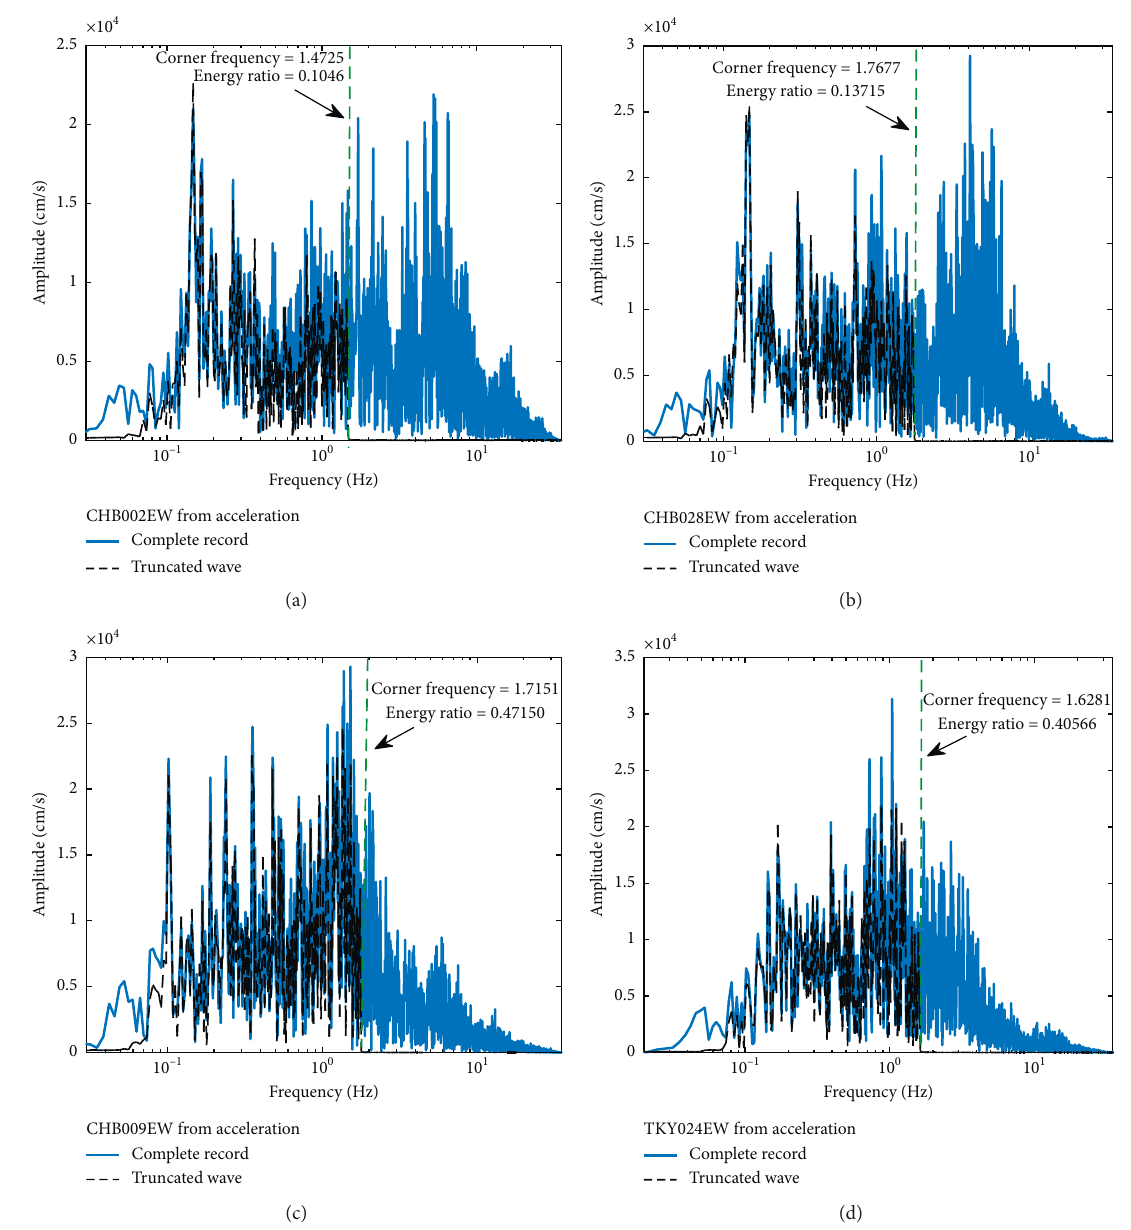
Figure 10: Comparisons of the Fourier amplitude spectra in terms of the complete record and truncated wave; (a) and (b) false positive records from CHB002EW and CHB028EW; (c) and (d) positive records from CHB009EW and TKY024EW. The Fourier amplitudes for the complete record and truncated waves are represented with solid and dashed lines,